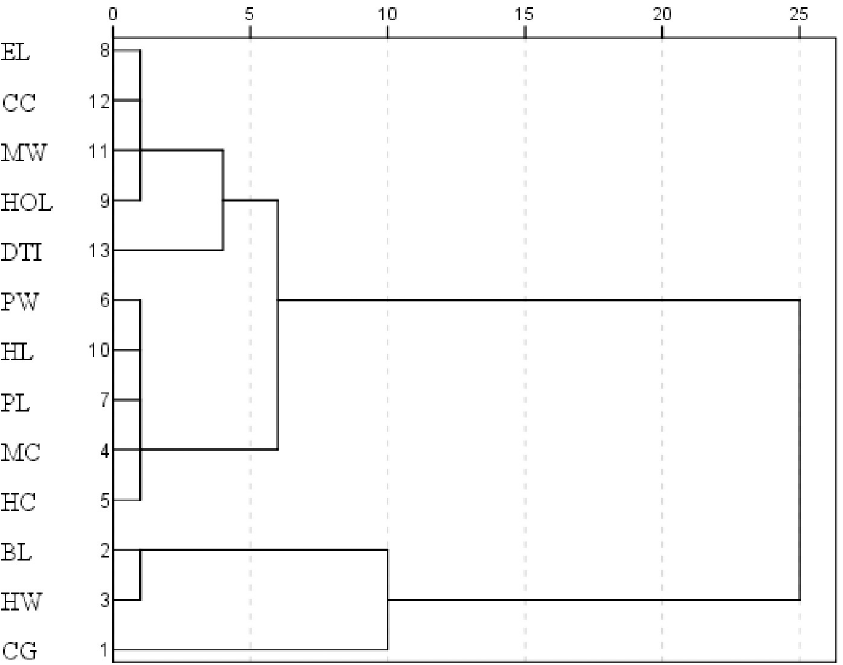
Fig 3. Dendrogram based on Euclidean distance. Dendrogram illustrating the morphometric relationships examined in the present study.